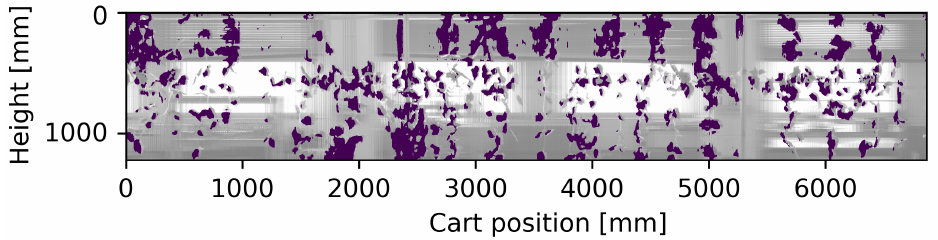
Figure 14. Estimated profile of vineyard with SfF system superimposed on the panoramic image of the test